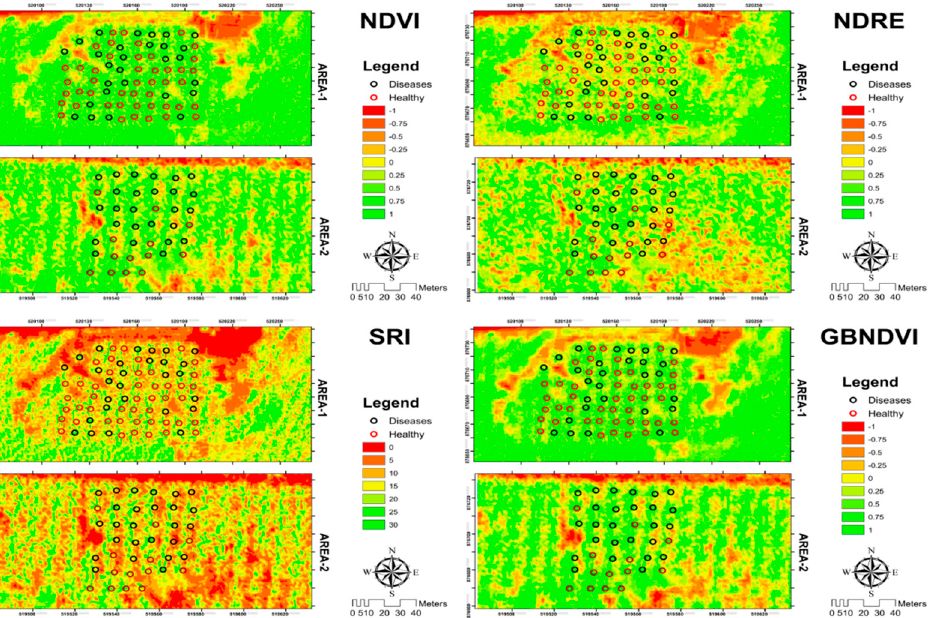
Figure 7. Visualization of the spectral vegetation indices (NDVI, NDRE, SRI and GBNDVI).